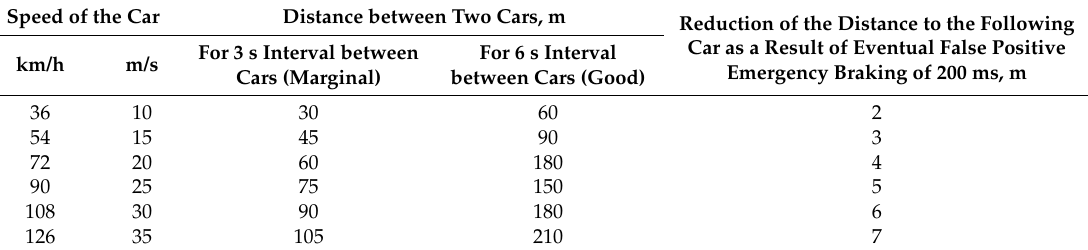
Table 14. The effect of FP on the reduction of distances to the following